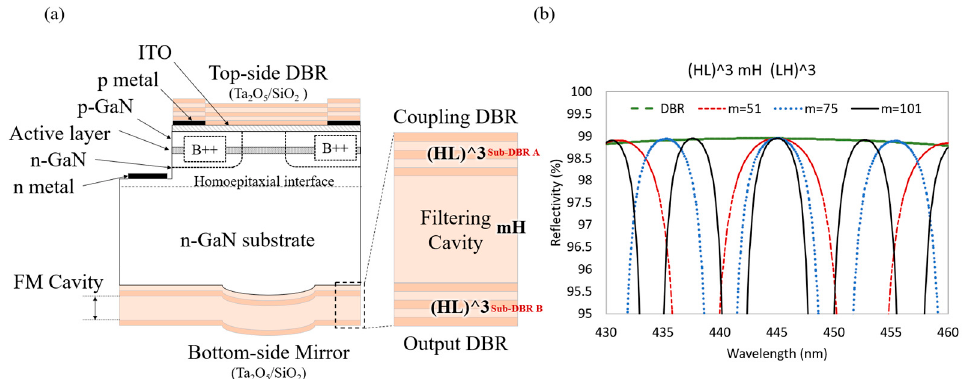
Figure 9. The schematic of a curved mirror VCSEL ( a ) with a bottom-side filtering mirror. The reflectivity spectrum of three different filtering mirrors ( b ) with a reference wavelength of 445 nm and cavities of m = 51, 75, and 101.